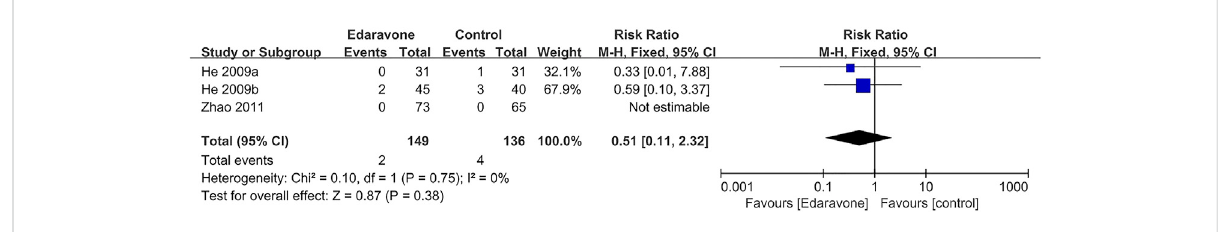
FIGURE 3 Forest plot for the effect of edaravone on all-cause mortality.